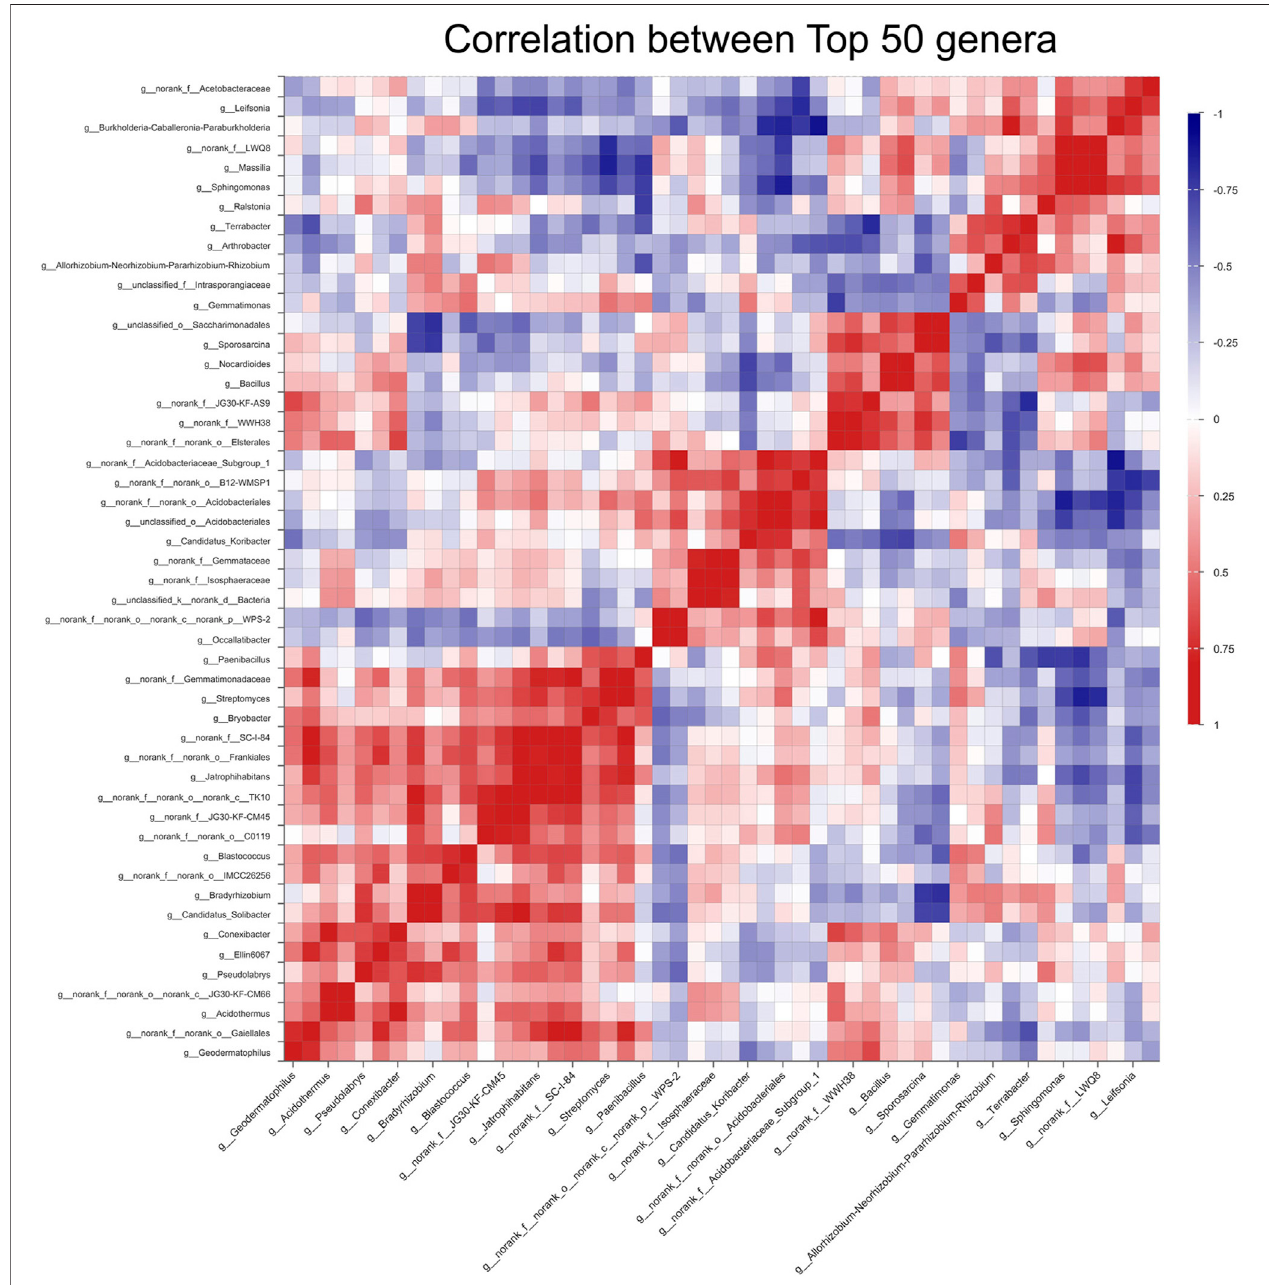
FIGURE 5 | Heatmap of the correlation between Top 50 genera among different